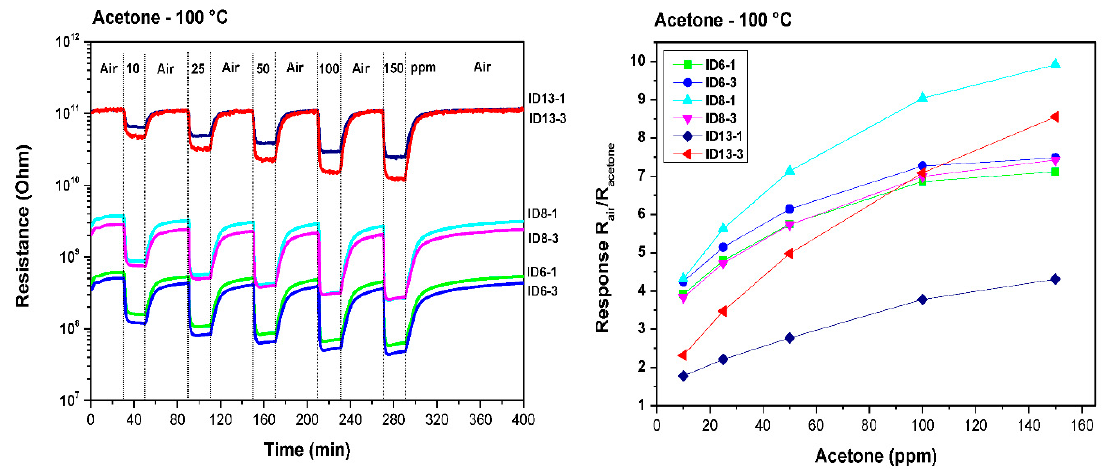
Figure 3. Dynamic profiles and resistance ratio responses of six different nanogap sensors at 100 °C to different acetone concentrations in dry